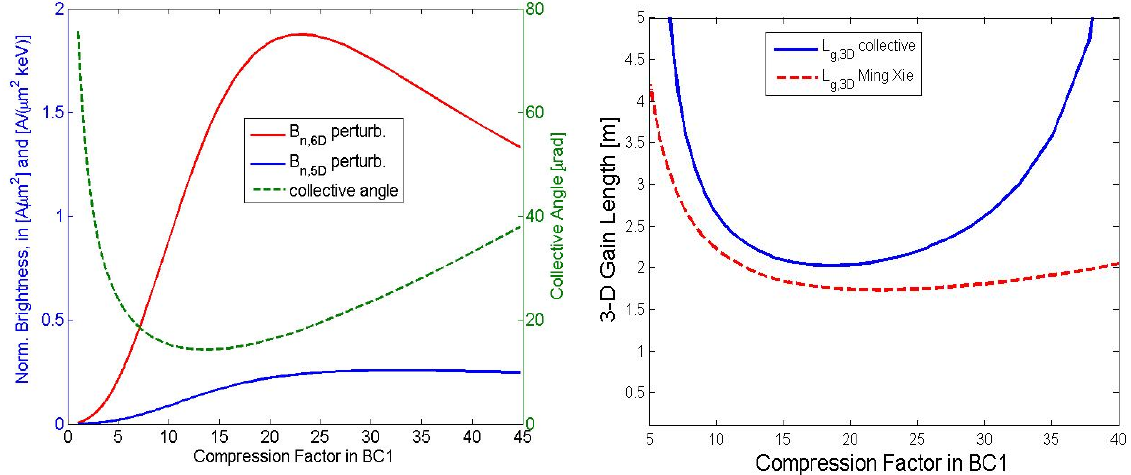
Figure 10. The final 5-D and 6-D normalized brightness and the collective angle are evaluated vs. the compression factor in BC1 (left panel), for a 500 pC bunch charge in the FERMI S-band linac (data from [48]). The 3-D gain length (right) is evaluated in the M. Xie sense and in presence of collective effects, for the same range of compression strengths. Pictures published in [48]. Copyright (2014) by The American Physical